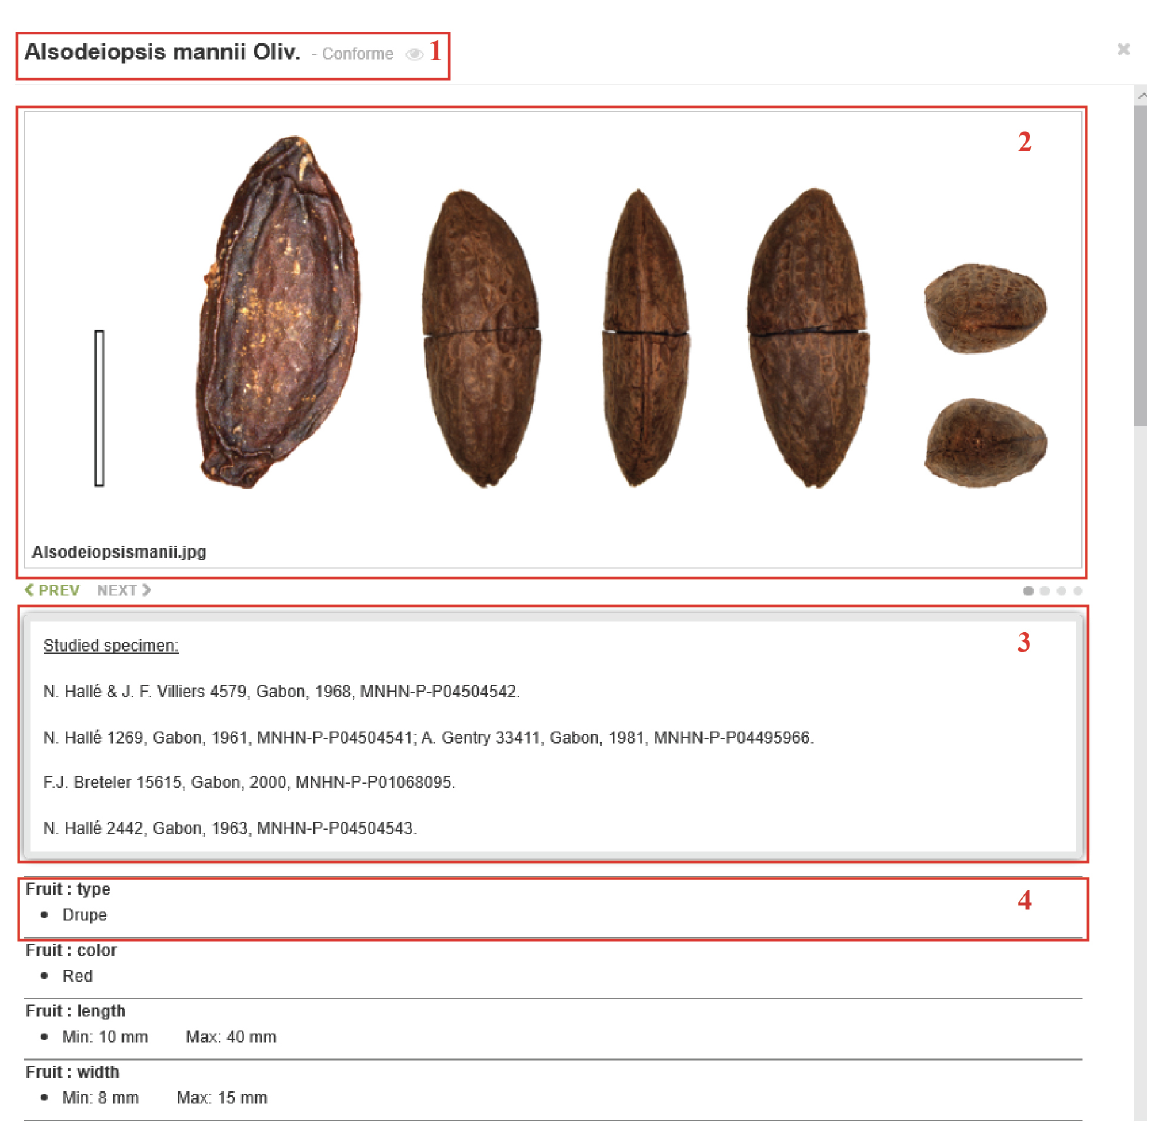
Fig. 5. View of remaining taxa in Interactive identification tab. 1 . Scientific name of the species. 2 . Pictures associated with the species. 3 . Studied specimens. 4 . Characters and character states of the